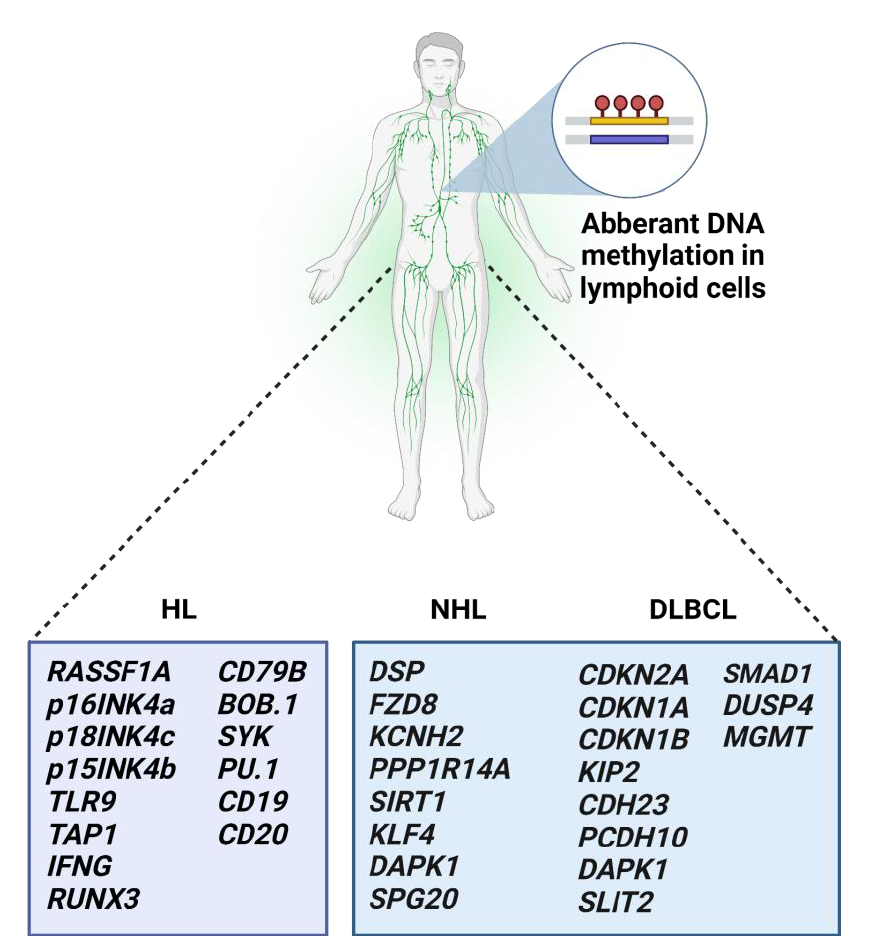
Figure 2. Methylation-affected genes associated with lymphomas. Aberrant DNA methylation (a red circle) regulates gene expression in Hodgkin, Non-Hodgkin, and Diffuse large B-cell lymphomas. Abnormally methylated genes might be used as potential biomarkers for therapeutic decisions and as predictive markers for patient